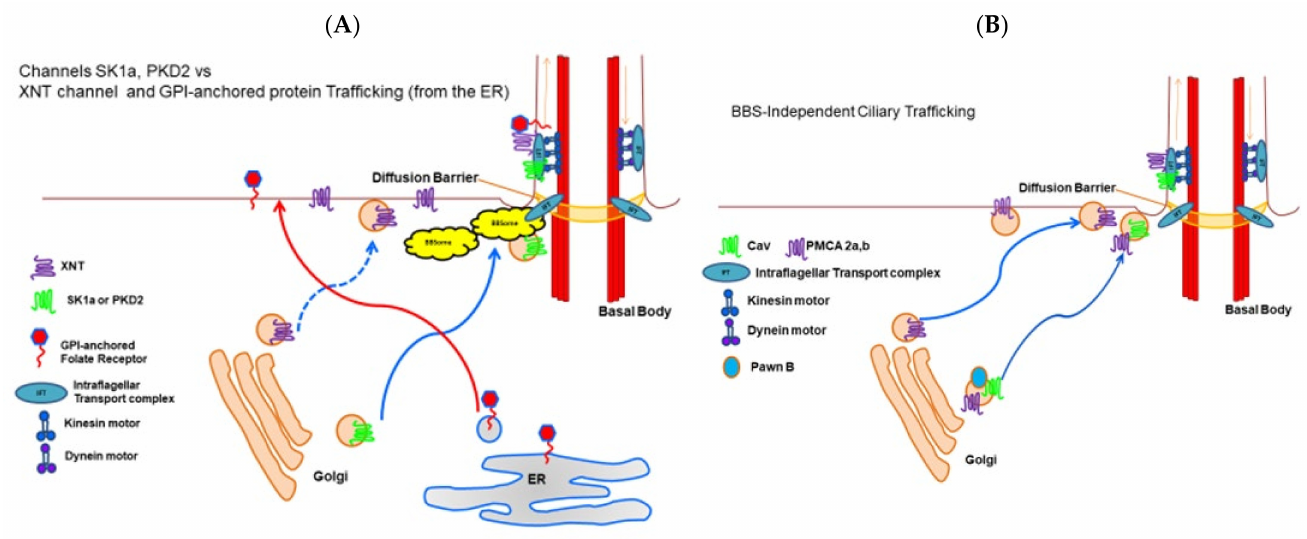
Figure 8. Summary cartoons of trafficking of membrane proteins to the cilia. ( A ) shows the folate receptor with its fatty acid tail moving from the ER directly to the plasma membrane before diffusing into the ciliary membrane. The XNT protein emerges from the Golgi on vesicles and moves to the plasma membrane and then to the contiguous ciliary membrane. The protein channels SK1a and PKD2 also emerge from the Golgi on vesicles but these vesicles are guided by the BBSome past the TZ and into the ciliary membrane. The motor proteins dynein and kinesin move the IFT complexes up and down the cilium and deposit their cargoes in the cilium. ( B ) shows that the calcium channel and its putative partner the plasma membrane calcium pump move on vesicles from the Golgi to the ciliary membrane without aid of the BBSome. When they reach the ciliary membrane, they are transported past the TZ and into the